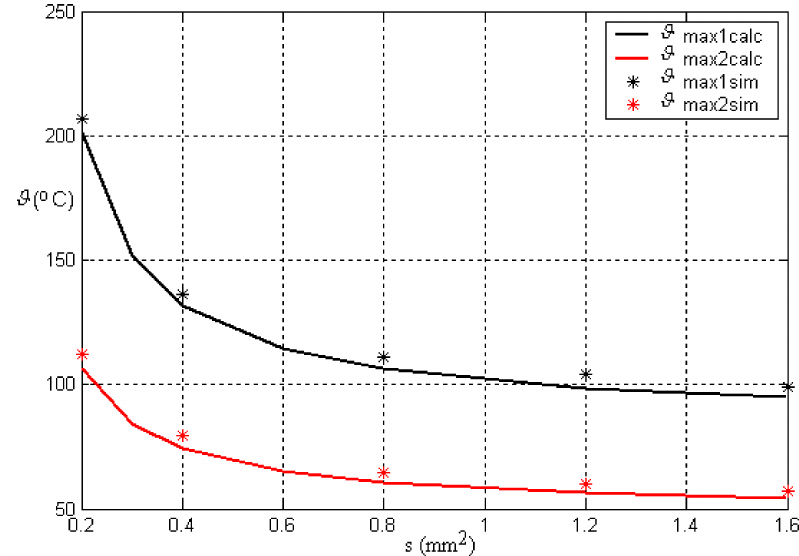
Figure 9. Maximum temperature rise variation for various notch cross-section values. Comparison between computed ( ϑ max 1 calc , ϑ max 2 calc ) and simulated values ( ϑ max 1 sim , ϑ max 2 sim